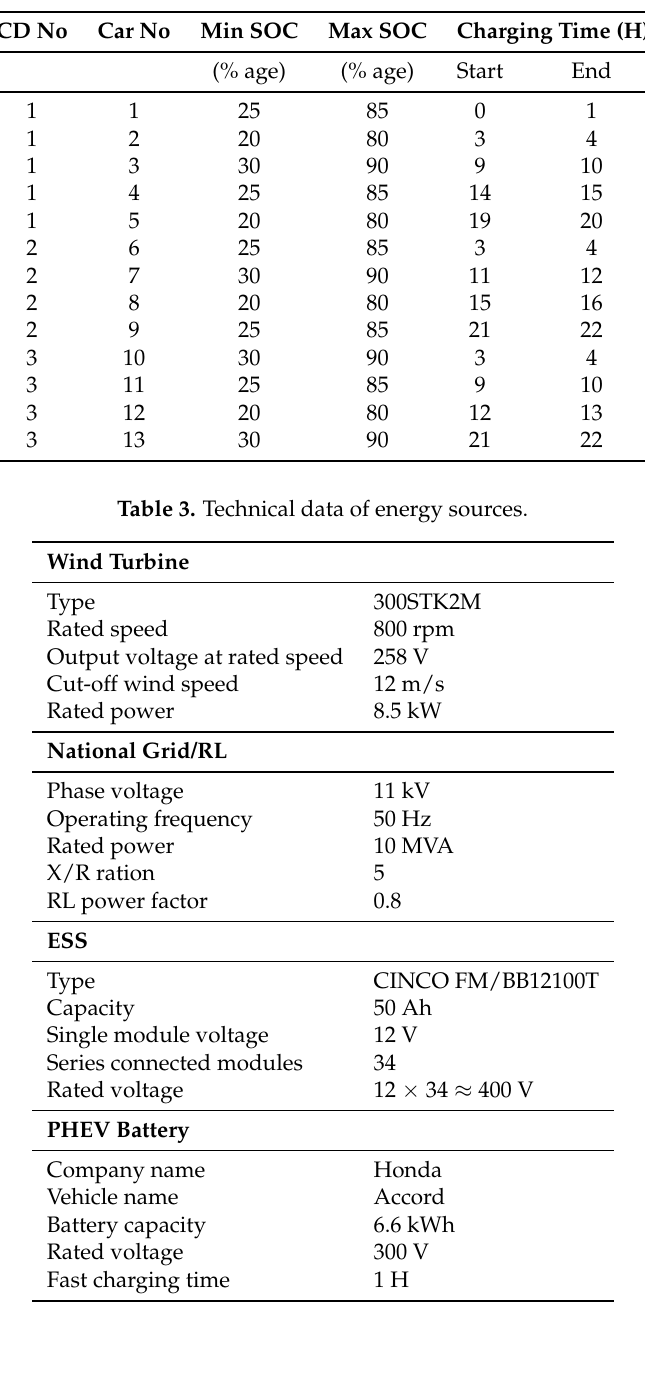
Table 2. Charging dock (CD) car’s schedule and their states of charge (SOCs).